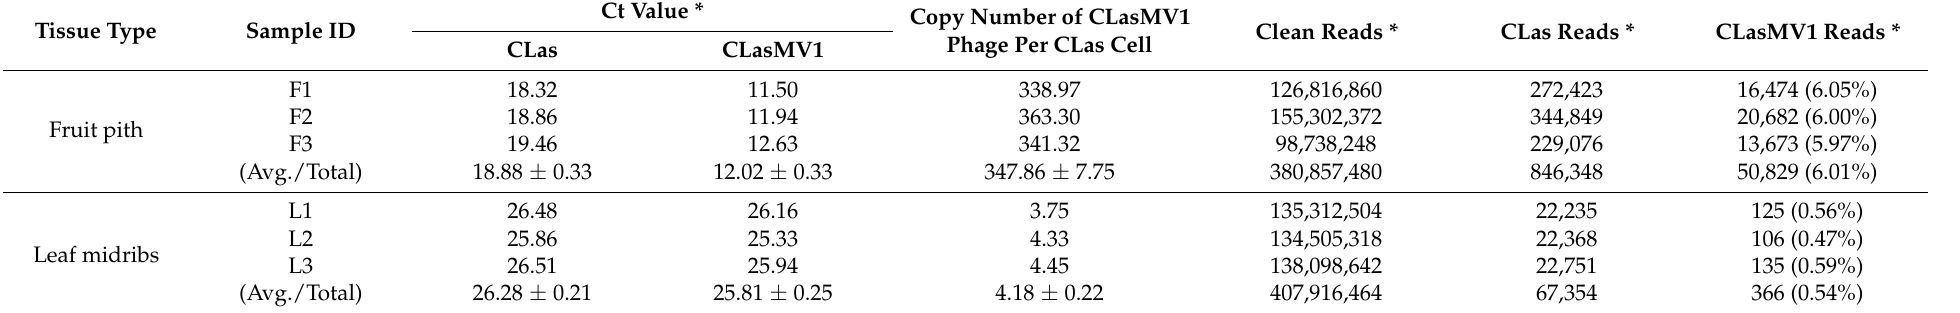
Table 3. General information of leaf midrib and fruit pith samples used for dual RNA-Seq.